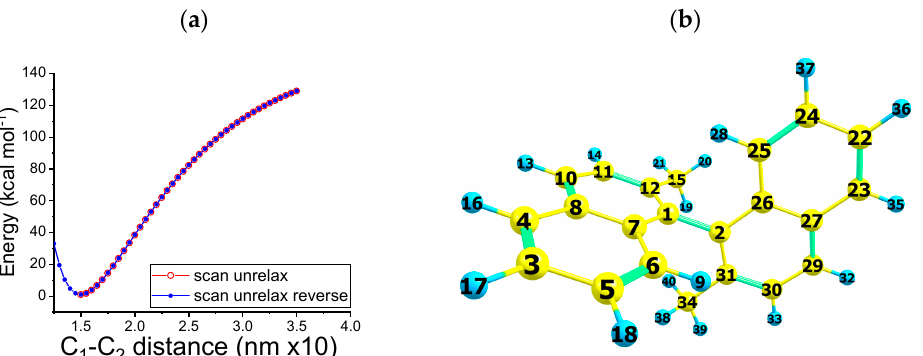
Figure 4. ( a ) Molecular potential energy vs. C 1 − C 2 distance for the neutral closed-shell dimer 1,1 (cid:48) -binaphthalene, 2,2 (cid:48) -dimethyl ( 4 ). UB3LYP/cc-pVTZ level of theory. Solvent effect (acetonitrile) accounted for by using Barone and Cossi’s polarizable conductor model (CPCM) ( b ) Bonds used to characterize the formation of the dimer: 𝐶 (cid:2869) − 𝐶 (cid:2870) 1,1 ′ -binaphthalene, 2,2 ′ -dimethyl.